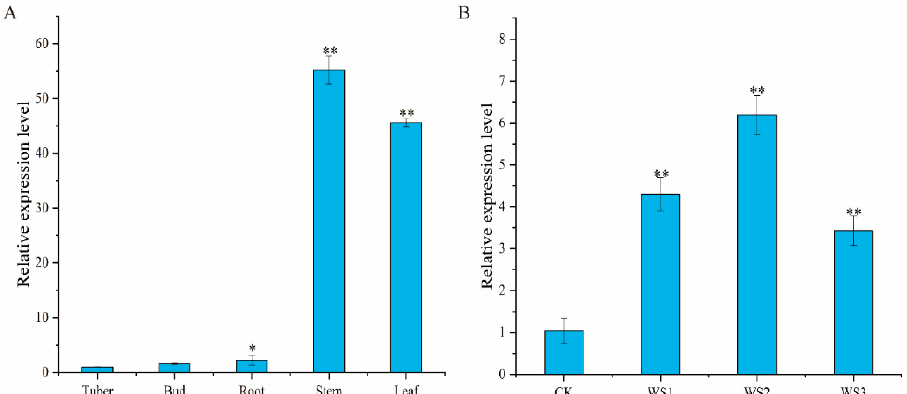
Figure 1. Analysis of potato StCIPK18 gene expression. ( A ) The relative expression level of StCIPK18 in different organs of potatoes. ( B ) Relative expression of the StCIPK18 gene under drought stress. CK: control; WS1: water stress group 1; WS2: water stress group 2; WS3: water stress group 3. Relative expression levels, determined by qRT-PCR, relative to the expression of the StEFla gene, are expressed as 2 − ∆∆ Ct . Each column represents the mean values ± SE ( n = 3; * p < 0.05; ** p < 0.01).